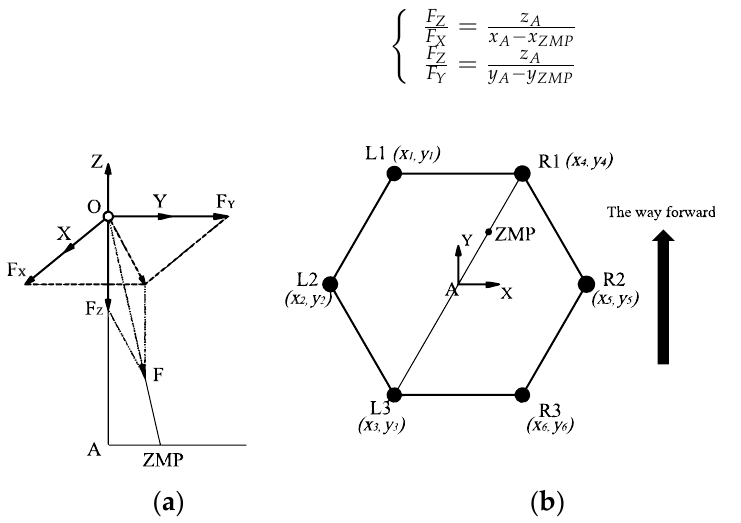
Figure 13. The stability analysis of robot bipod gait. ( a ) The schematic diagram of ZMP point location. ( b ) The stability analysis model of bipod gait.